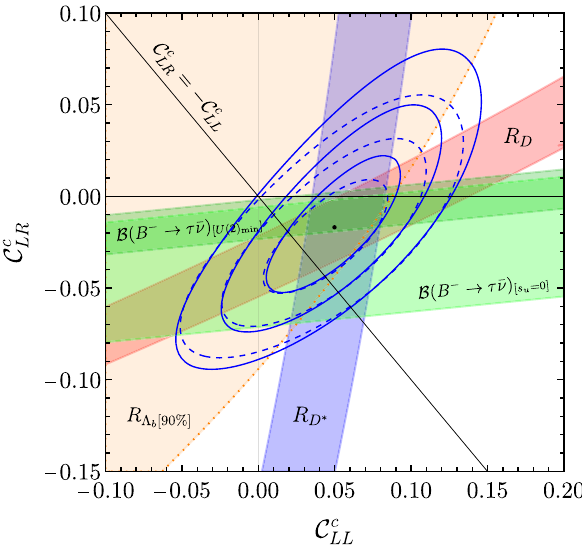
Fig. 1 Determination of C c and C c from a χ 2 -fit to low-energy LL LR observables. The Wilson coefficients, assumed to be real, are renormal- ized at the reference scale (cid:12) UV = 1 TeV. The blue ellipses denote the 1,2,and3 σ contoursfittingonly b → c observables.Theblackdotindi- cates the best fit point of ( 0 . 05 , − 0 . 02 ) . The dotted lines are obtained (cid:24) (cid:23) B − u → τ ¯ ν inthelimitofupalignment.The (cid:13)χ 2 = 1 includingalso B regions preferred by each observable are also indicated, except in the case of R